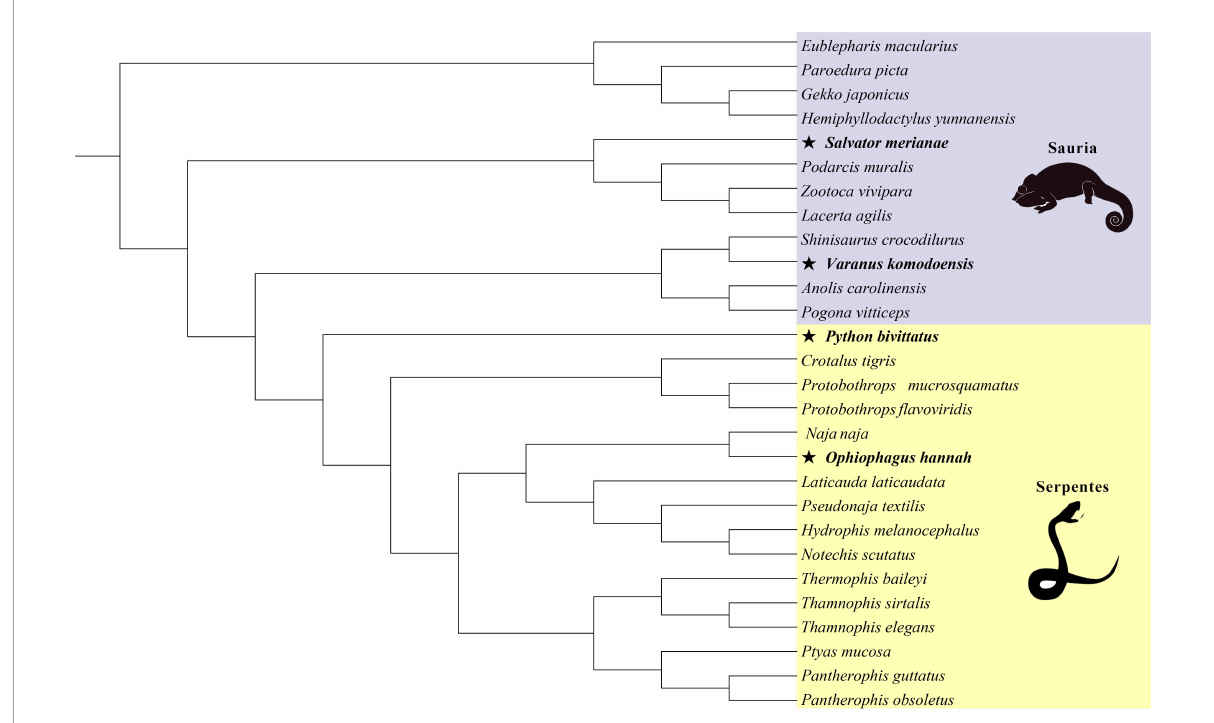
FIGURE1 The phylogenetic relationship of 28 squamate reptiles based on maximum-likelihood method (asterisk represents large-bodied species in lizards and